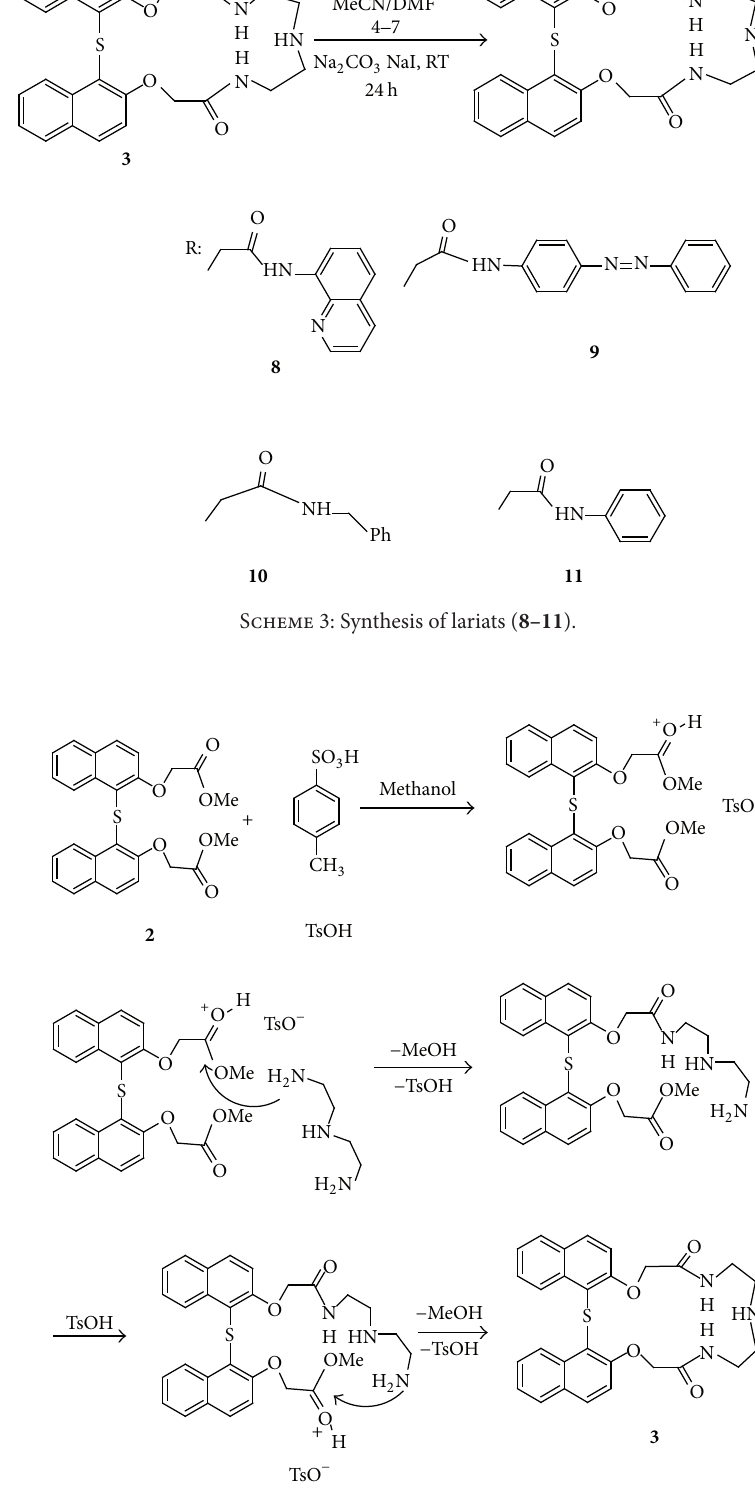
F 2: Proposed mechanism for the formation of macrocycle ( 3